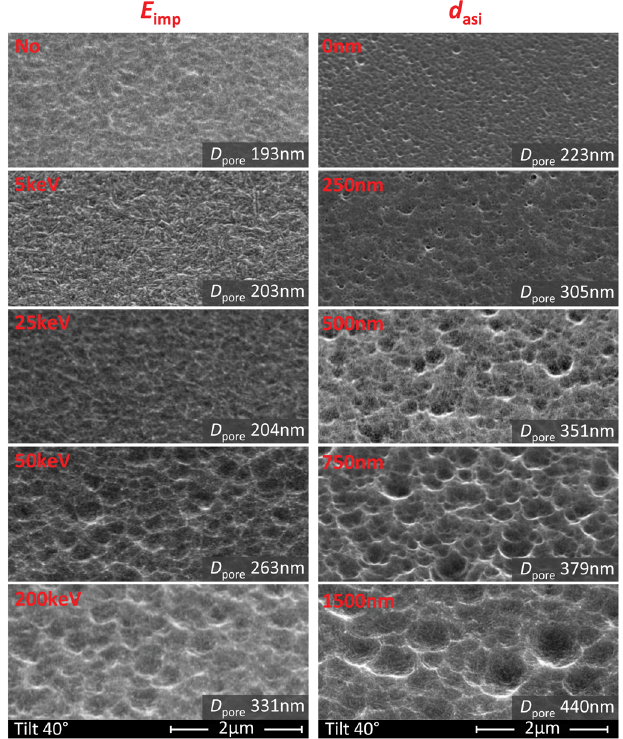
Fig. 4. SEM images and D pore values of two argon implanted series of samples. Samples on the left are processed with increasing E imp and d asi = 1 m m. Samples on the right are processed with increasing d asi and E imp = 250 keV. All samples implanted with (cid:3) 2 . No implantation occurred for the top-left d imp =1e16 cm sample, while the implantation was performed without amor- phous silicon layer for the top-right